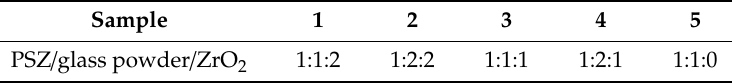
Table 2. Composition ratios of ceramic slurries (volume